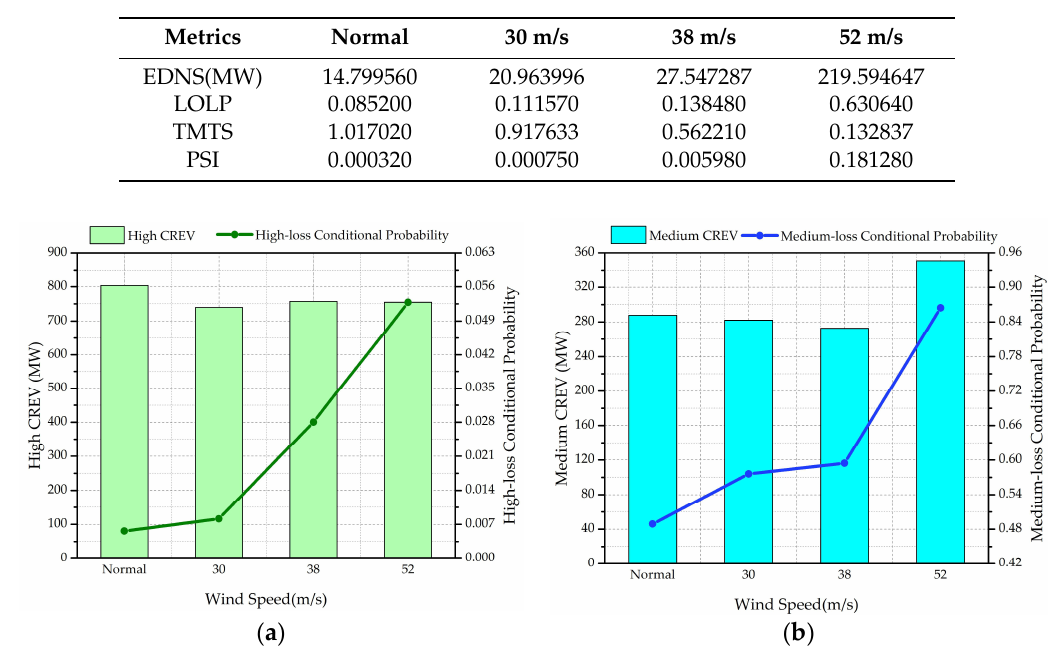
Figure 5. CREV and condition probability for high and medium loss: ( a ) The PMRM assessment results for high loss; ( b ) The PMRM assessment results for medium loss.